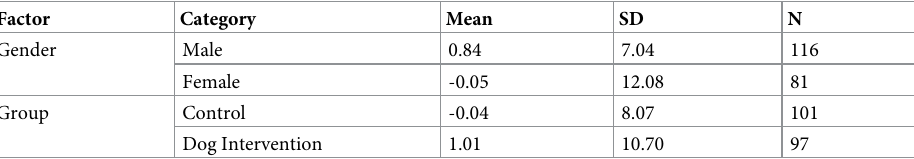
Table 16. Descriptive statistics for blood